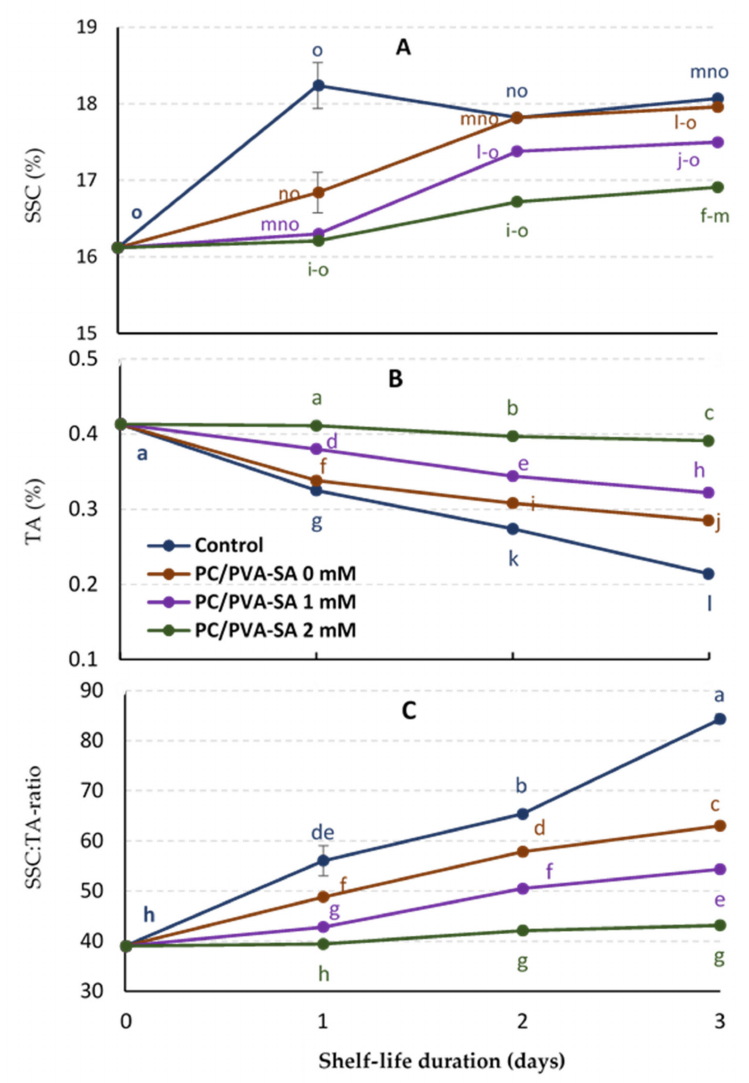
Figure 5. SSC (%) ( A ), TA (%) ( B ), and SSC: TA-ratio ( C ) of ‘Crimson seedless’ grapes coated with PE + PVA blending with SA at different concentrations (0, 1, and 2 mmol L − 1 ) and stored at room temperature (26 ± 1 ◦ C and 65 ± 5% RH) for 3 d. Each value represents a mean of three replicates, with error bars representing standard errors ( ± SE), and different letters indicate significant differences at p ≤ 0.05 between treatments. Mean comparisons were performed between all